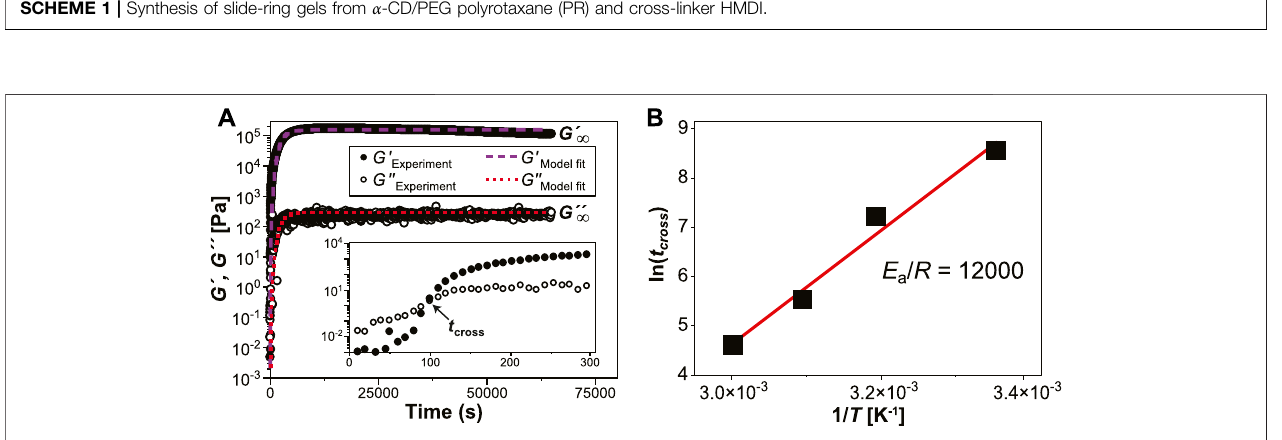
FIGURE1|(A) Chemorheologicaltimesweepofsample P 10 C 5 T 60 over68,400 s(18 h)showtheplateaumoduli( G ′ ,G ″ )whengelationiscomplete.Insetmagni fi es the gel point at crossover time ( t cross ) in the fi rst 300 s. (B) Activation energy of gelation. An Arrhenius plot of t cross against 1/ T gives an activation energy of 96 kJ/mol for the cross-linking